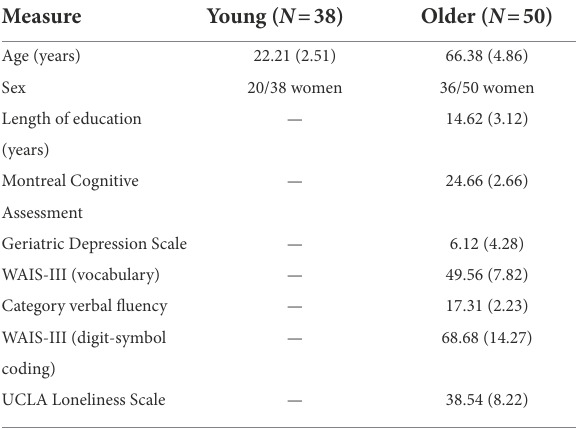
TABLE 1 Participant